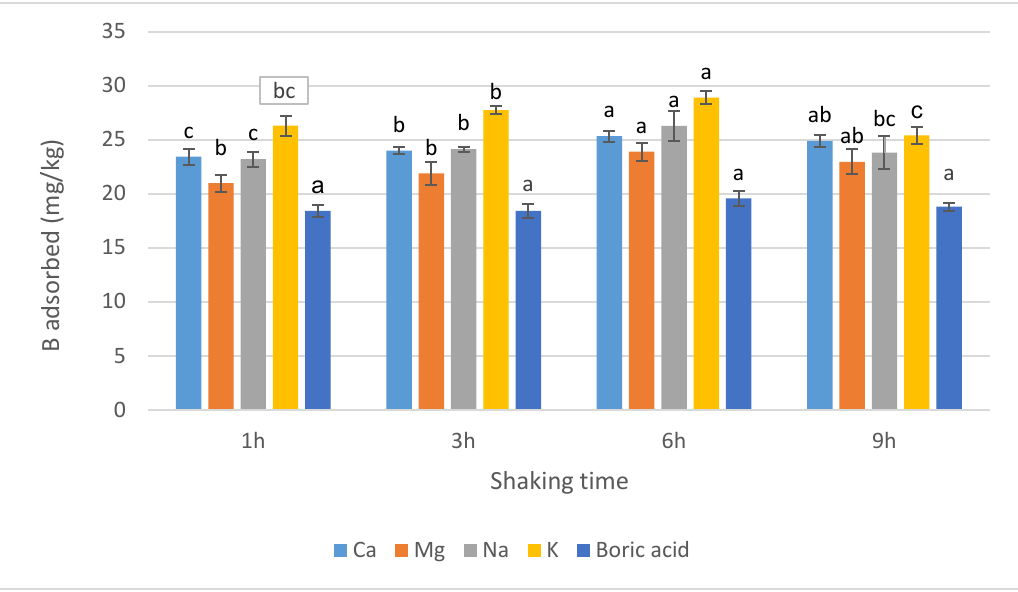
Fig.3: B adsorbed in Soil‐A with different time of shaking in TBCa, TBMg, TBNa, TBK and TBo (Different letters indicate significant differences among the different time of shaking at P<0.05 level and at the same treatment)